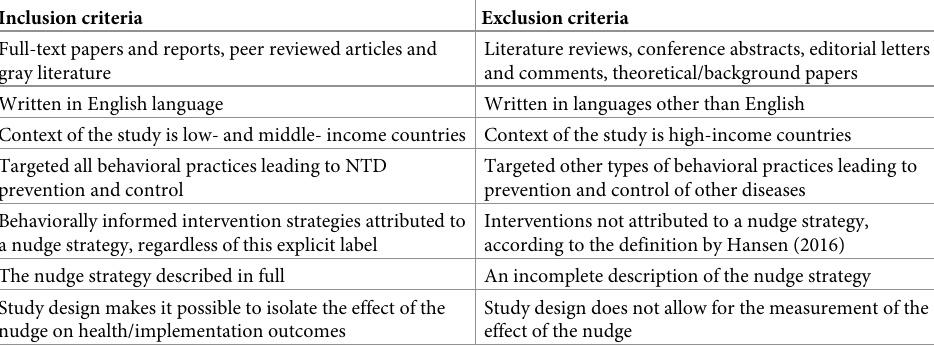
Table 1. Final eligibility